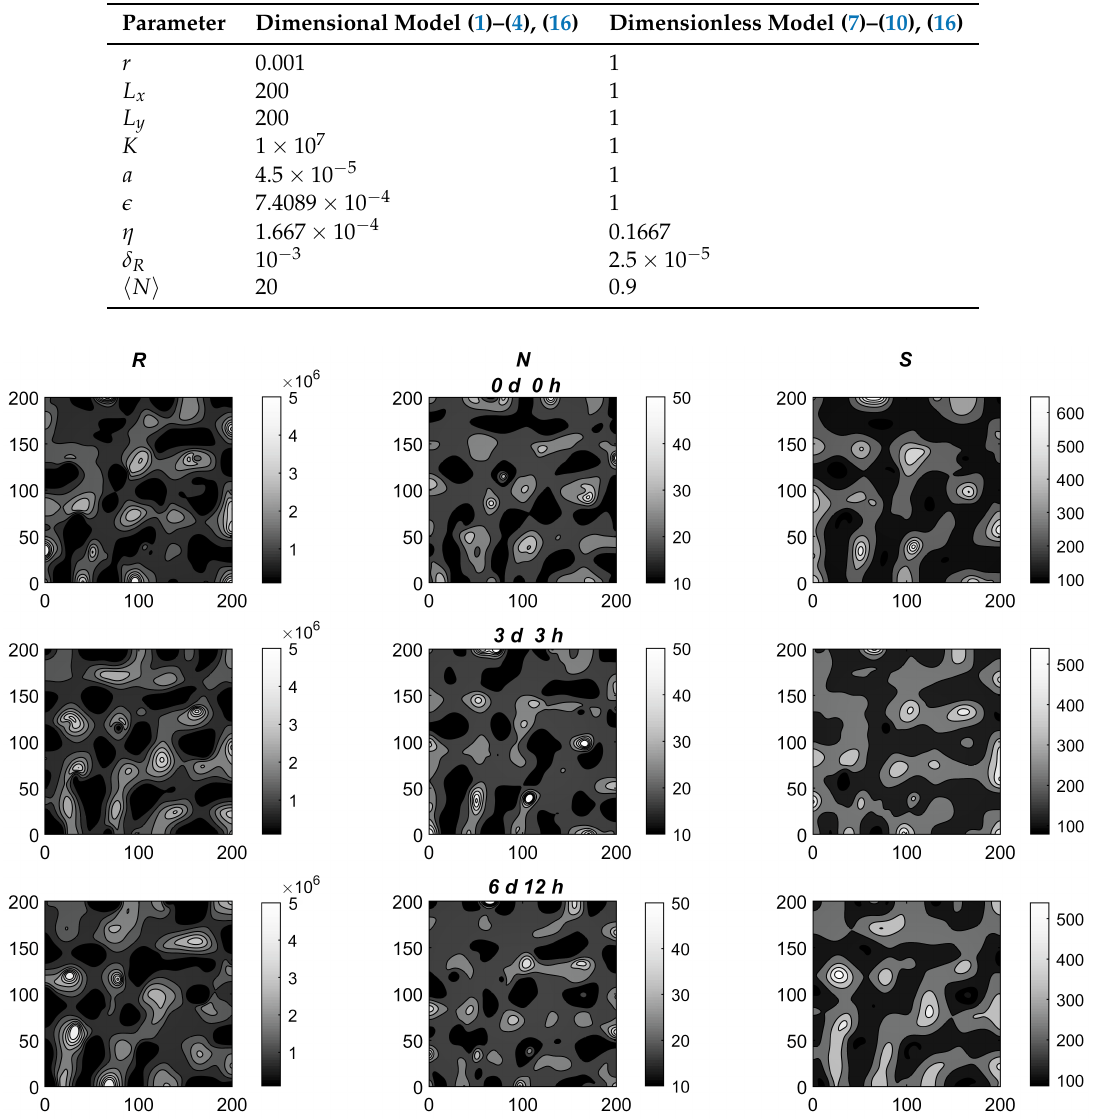
Table 4. Values of the model parameters used in simulations.